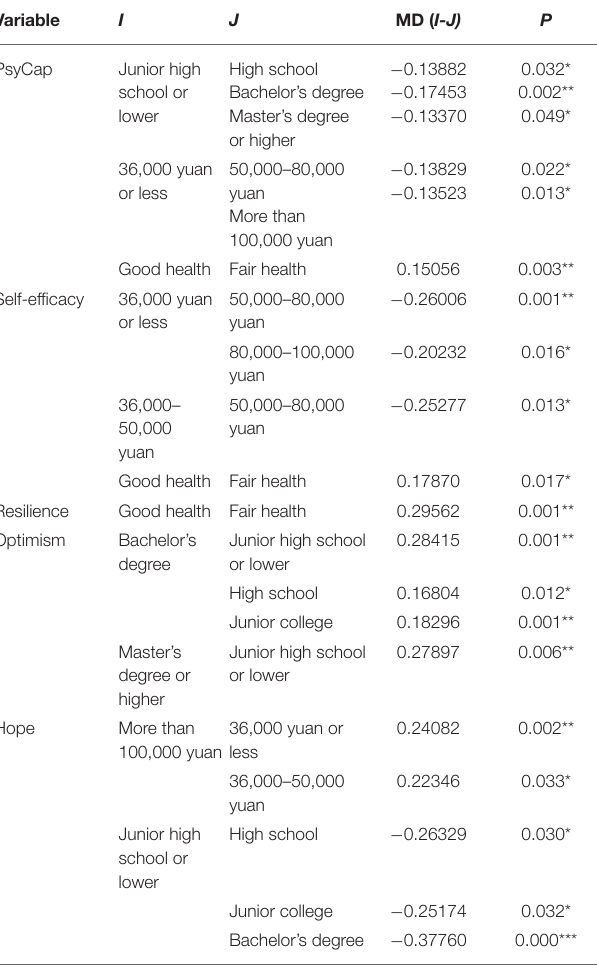
TABLE 8 | Results for one-way analysis of variance about individual characteristics of citizens who will actively participate in food safety social co-governance.